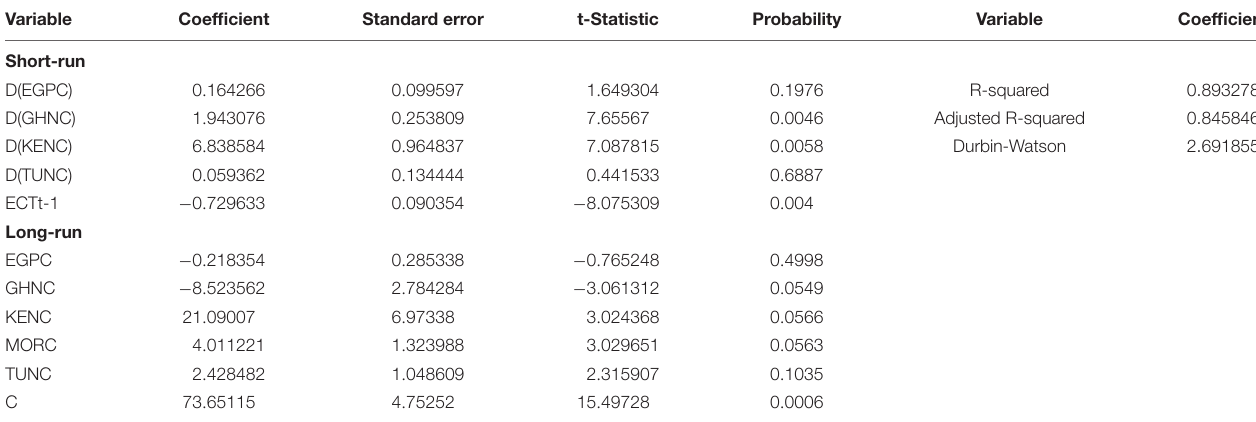
TABLE 8 | Long-run and short-run parameters of ARDL model E. Variable